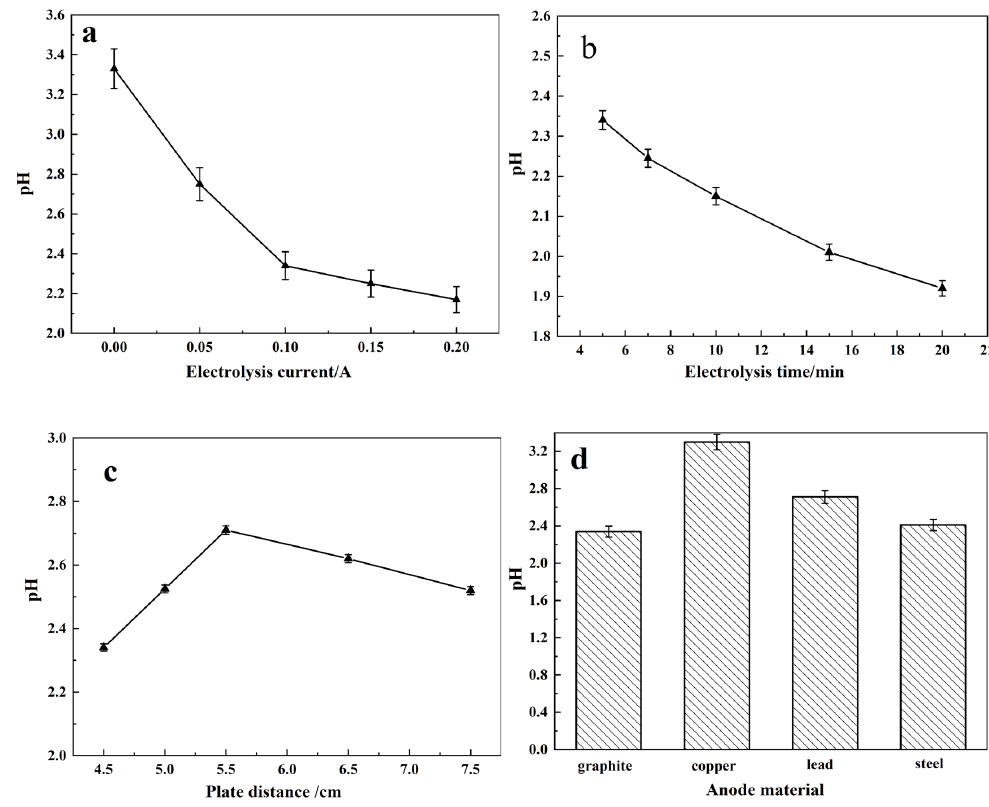
Figure 7. Influence of electrochemical pretreatment on pH value of copper sulfate solution. (c(Cu 2+ ) = 6 × 10 −5 mol/L). ( a ), electrolysis current; ( b ), electrolysis time; ( c ), plate distance; ( d ), electrode material types.